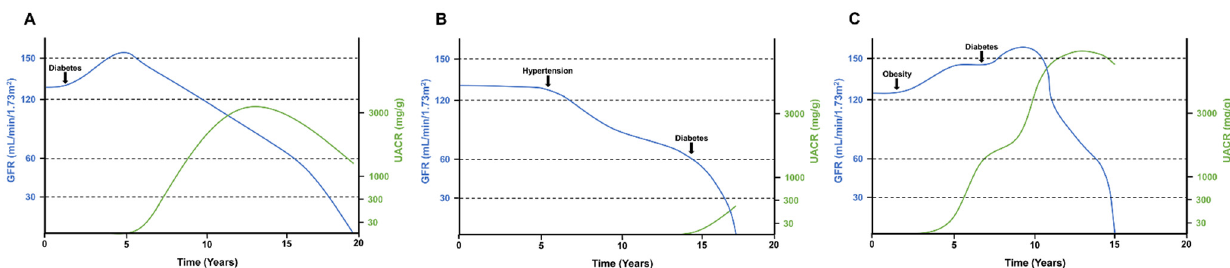
Figure 1. Glomerular filtration rate and albuminuria over time in three different hypothetical situations of DKD. GFR decline and albuminuria can vary in patients with DKD depending on previous comorbidities and the timing of harmful events. ( A ) Classical phenotype of DKD with an initial hyperfiltration phase and later development of progressive albuminuria. As the disease advanced to overt nephropathy, GFR decline was observed. ( B ) Non-proteinuric DKD in a patient that had hypertension before a diabetes diagnosis. Note that mild albuminuria appeared only when the patient had advanced CKD. ( C ) Glomerular hyperfiltration in an obese patient that later developed diabetes. As hyperfiltration progressed, the patient developed massive albuminuria followed by a rapid decline in GFR. UACR: urinary albumin-to-creatinine ratio. GFR: glomerular filtration rate.